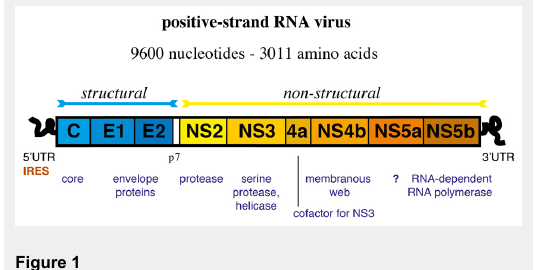
Genetic organisation of hepatitis C virus (HCV). Internal ribosomal entry site (IRES)-mediated translation of the positive-strand RNA genome yields a 3011 long polyprotein that is cleaved into 10 proteins by cellular and viral